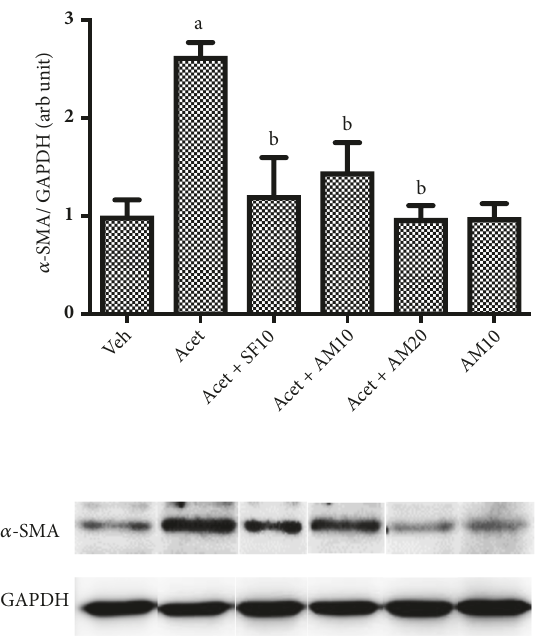
Figure 4: Effect of alpha mangostin in HSC activation as shown by the expression of 𝛼 -SMA/GAPDH after LX-2 cells were treated with alpha mangostin with or without acetaldehyde induction. Results were presented as mean ± SEM. a: p < 0.05 versus untreated group, b: p < 0.05 versus acetaldehyde group. Veh: vehicle only, Acet: acetaldehyde 100 𝜇 M, Acet+ SF10: acetaldehyde 100 𝜇 M + sorafenib 10 𝜇 M, Acet + AM10: acetaldehyde 100 𝜇 M + alpha mangostin 10 𝜇 M, Acet + AM20: acetaldehyde 100 𝜇 M + alpha mangostin 20 𝜇 M, AM 10: alpha mangostin 10 𝜇